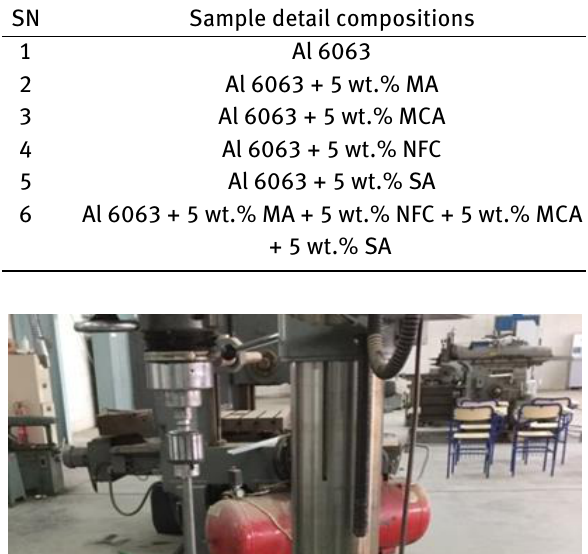
Table 6: Al 6063 alloy and their constituents. SN Sample detail compositions